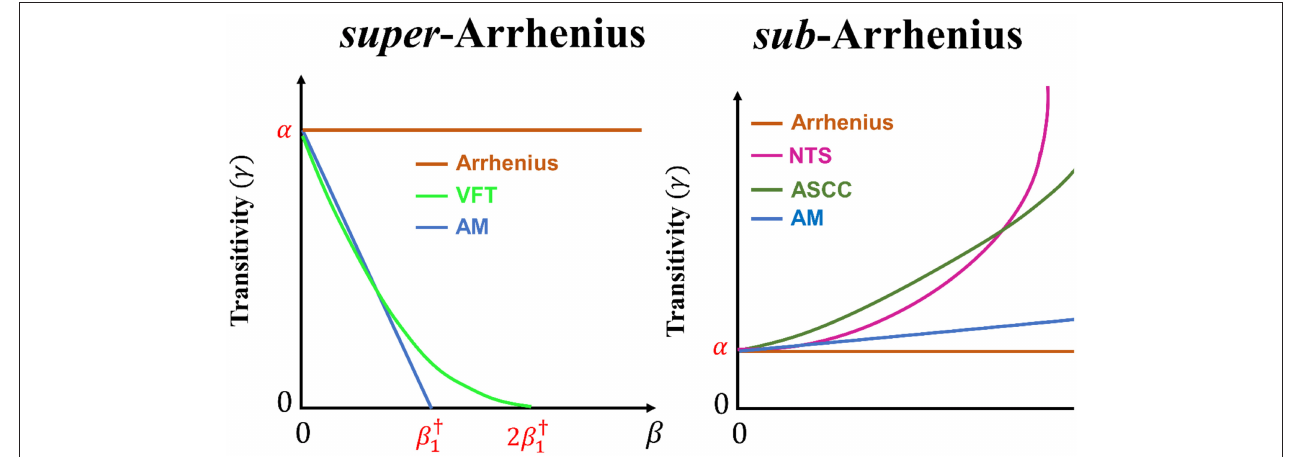
FIGURE 2 | The transitivity plot is presented for venerable and recent phenomenological reaction rate constant model to account for super -Arrhenius behavior (Arrhenius, AM, and VFT) and sub -Arrhenius behavior (Arrhenius, AM, ASCC, and NTS). The comparison of the behavior of the transitivity between AM and VFT is exhibited assuming ε ‡ 1 = ε ‡ 2 in Equation